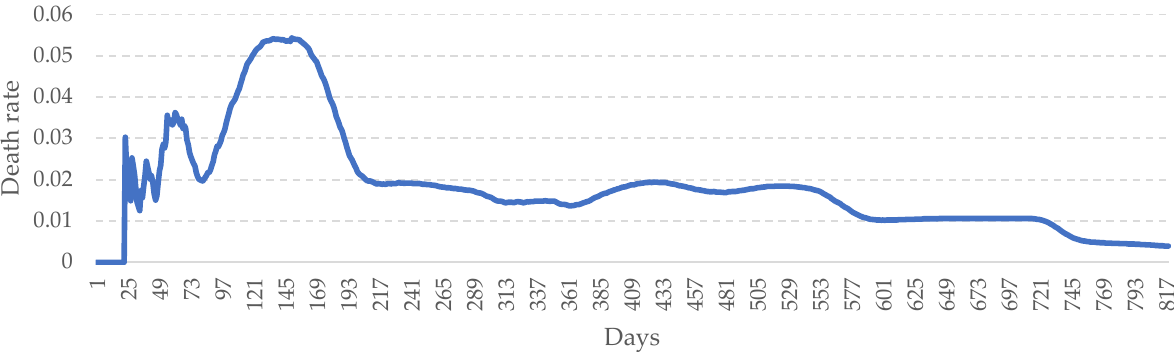
Figure 6. Daily death rate in Japan. (January 2020–April 2022).